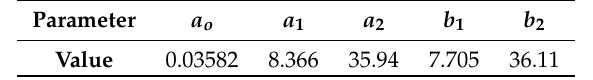
Table 3. Ammonia reaction effectiveness factor